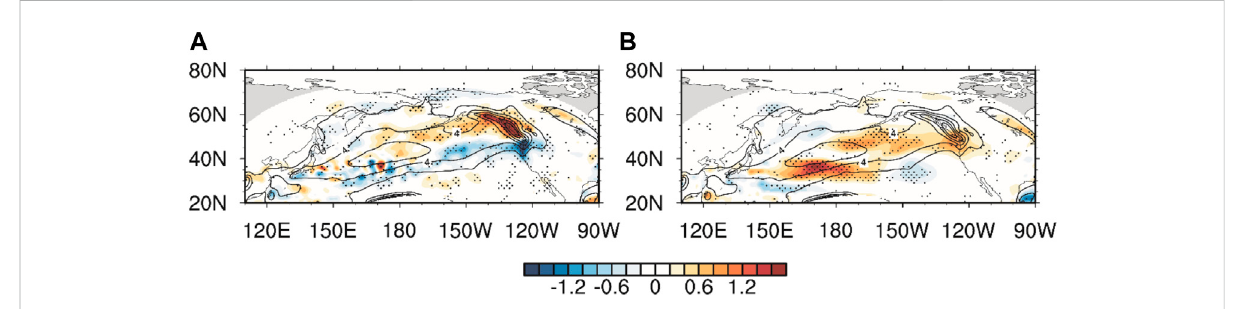
FIGURE 5 Winter mean precipitation (10 – 4 kg m − 2 s − 1 , shading) for (A) KE-related mesoscale SSTAs (KSTS-MEFS) and (B) KE-related large-scale SSTAs (MEFS-CTRL). The isoline is the climatological precipitation simulated by the model (CTRL). Statistically signi fi cant differences at 90% according to Student ’ s t test are